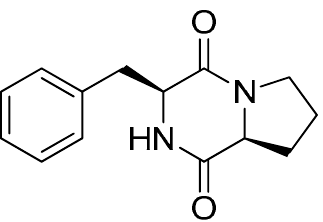
Figure 2. Chemical structure of 1, cyclo (L-Pro-L-Phe) isolated from Paraphaeosphaeria sporulosa .